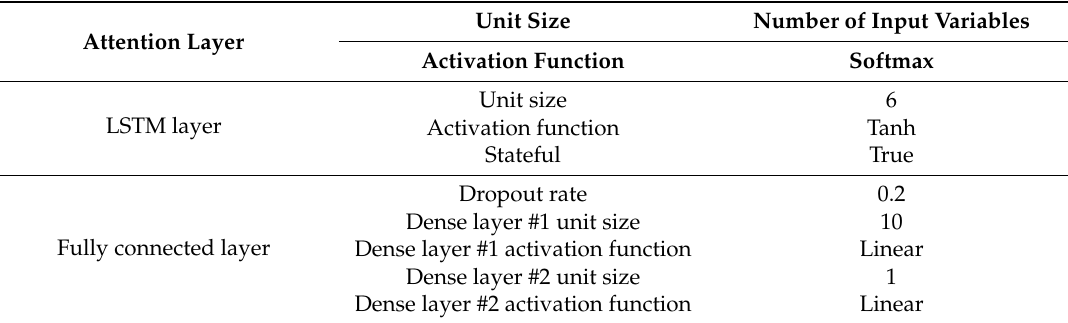
Table 2. Hyperparameters setting.